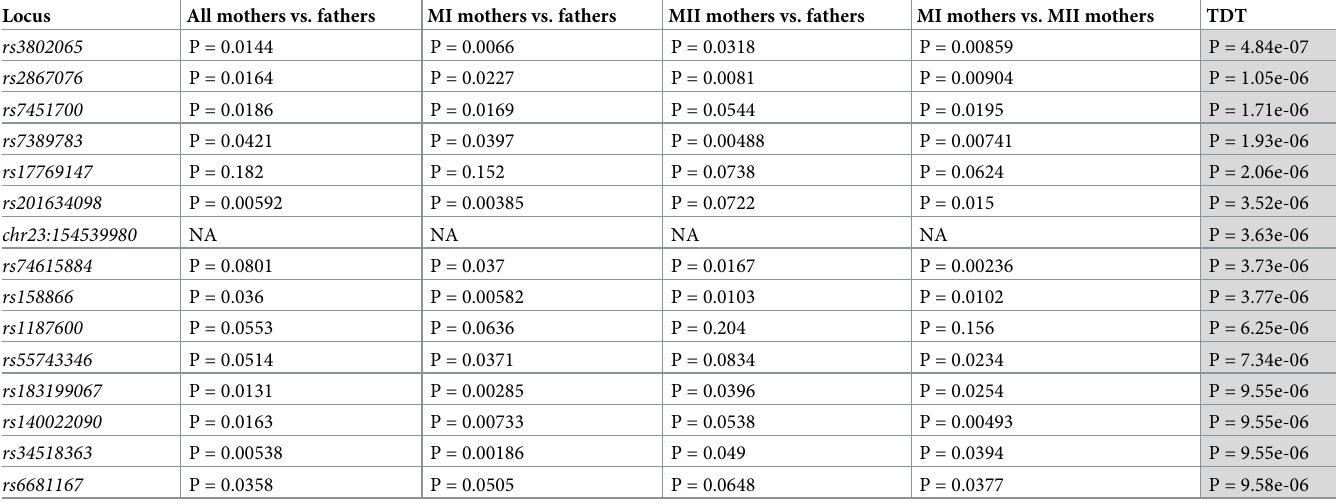
Table 7. Top hits from the TDT (transmission disequilibrium test) genome-wide association study. Locus All mothers vs.